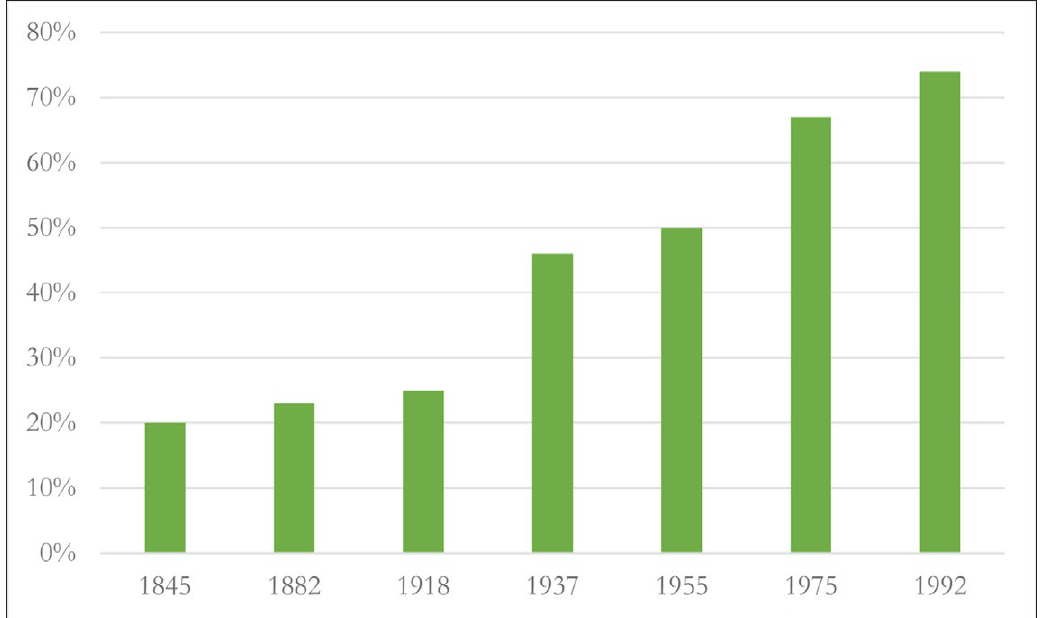
Figure 1: Overt pronominal subjects in BP through seven periods. 3 (Barbosa, Duarte & Kato 2005: 6; adapted from Duarte